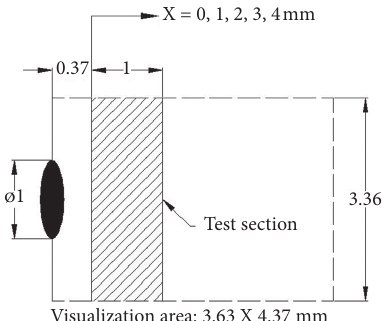
Visualization area: 3.63 X 4.37 Figure 14: Test sections for visualization.